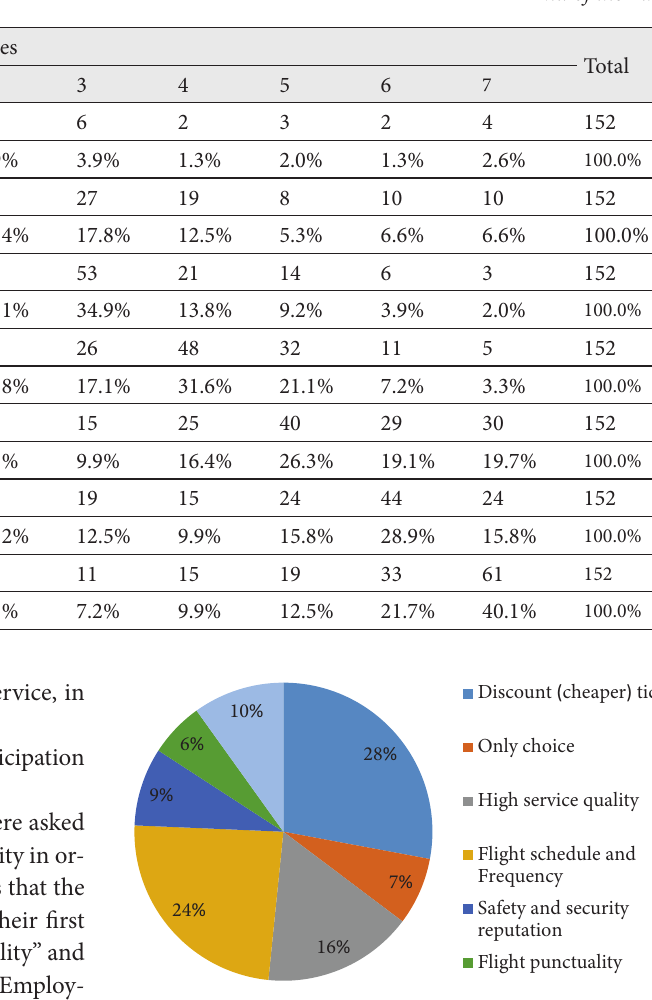
Fig. 1. Respondents reasons for selecting an airline for domestic travel in